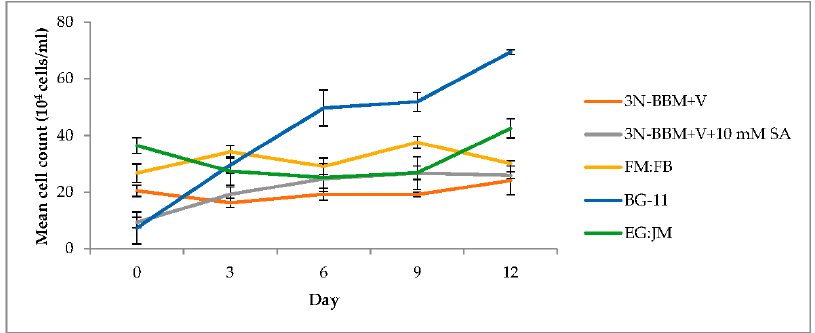
Figure 4. Growth of H. pluvialis after re-suspension of green stage culture in astaxanthin production inducting conditions. Mean cell count data ± S.D. ( n = 3). The red stage involved culturing at 20 °C, continuous light at 240 µmol photons m − 2 ·s − 1 .